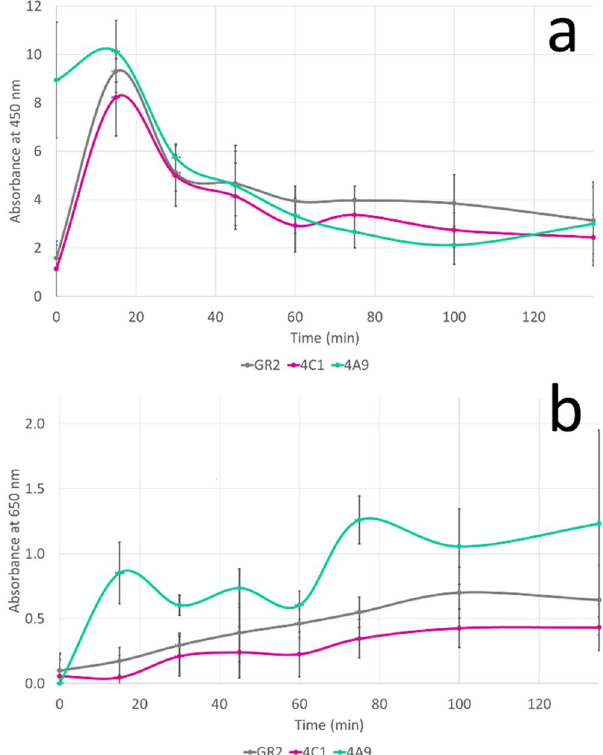
Figure 7. Changes in humic acids ( a ) and fulvic acids ( b ) presence during process of brown coal modification by laccase